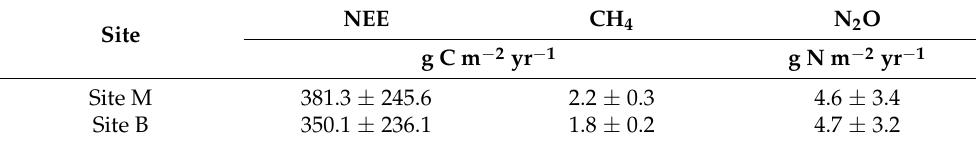
Table 5. C-N emissions (NEE: net ecosystem CO 2 exchange; CH 4 : methane; and N 2 O: nitrous oxide) from the two study sites (baseline climate), estimated (30-year mean with standard deviation) using PaSim. The estimated components of the C budget (GPP: gross primary production; RECO: ecosystem respiration) can be found in Supplementary material (Table S4).